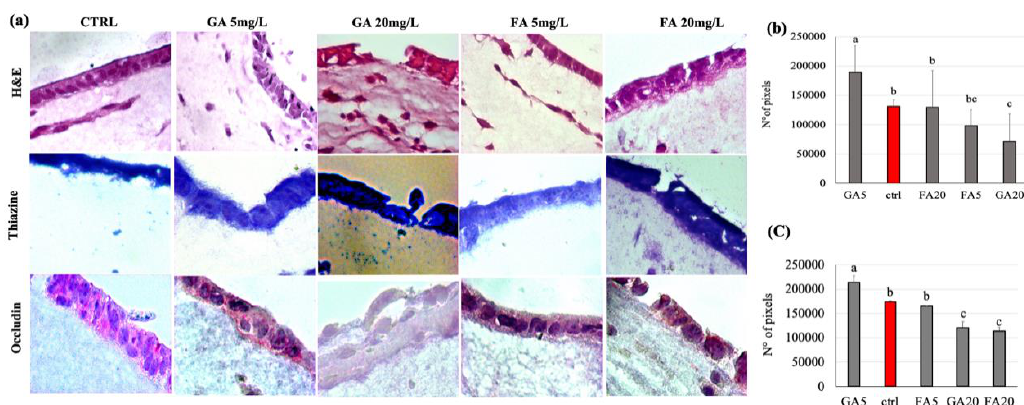
Figure 6. Intestinal equivalents obtained by seeding Caco2 cells on dermal equivalents that were paraffin-embedded. ( a ) Sections were stained with hematoxylin and eosin (H&E), thiazine and occludin markers; Fast Red was used as a chromogen. ( b ) The thickness of the epithelial layer was measured by image pixel count using ImageJ 2.0.0-rc-69/1.521 ( c ) Stained areas were evaluated by image pixel count using ImageJ 2.0.0-rc-69/1.521. Experiments were conducted in triplicate from different samples. Statistical analysis was performed, and between brackets, different letters indicate mean values that are significantly different at p < 0.05.